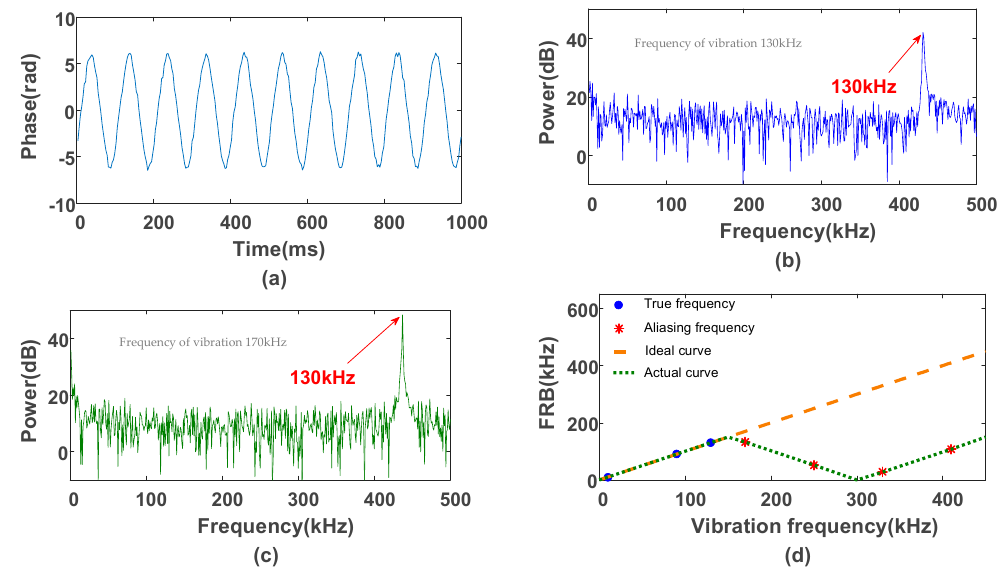
Figure 15 . The detection results of a system with single-pulse. ( a ) The phase of 10kHz vibration; ( b ) Power spectra of 130 kHz vibration; ( c ) Power spectra of 170 kHz vibration; ( d ) Detection frequency and ideal curve